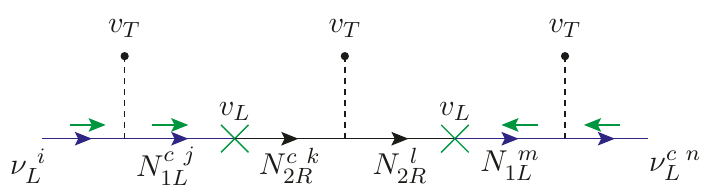
Figure 1 . Diagrammatic representation of the ǫ 3 -suppression for the active neutrino masses. Su- perscripts denote family indices. Upper(green) arrows denote flow of lepton